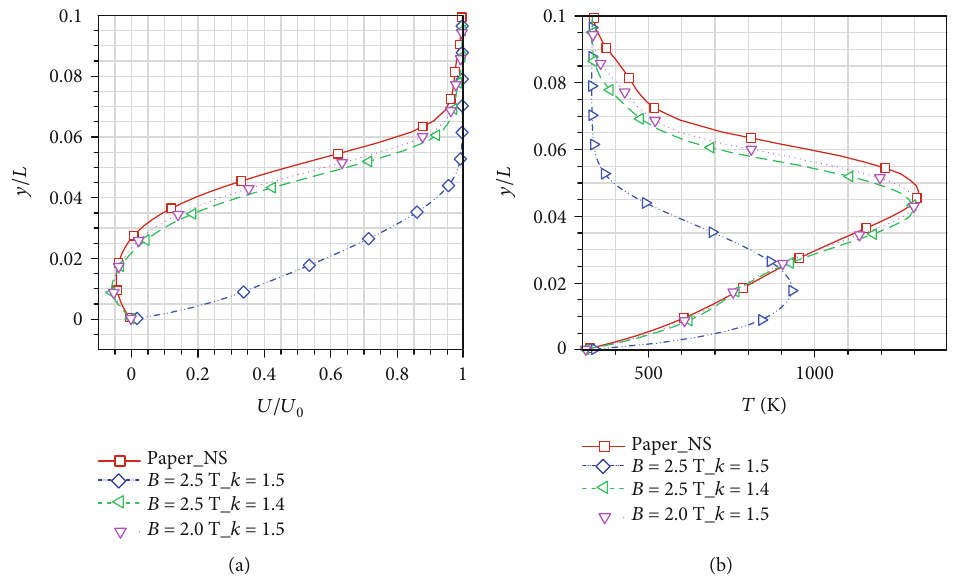
Figure 15: Velocity and temperature pro fi les near the corner at x / L = 0 : 9 under di ff erent electromagnetic fi eld strengths: (a) pro fi les of velocities; (b) pro fi les of temperatures.